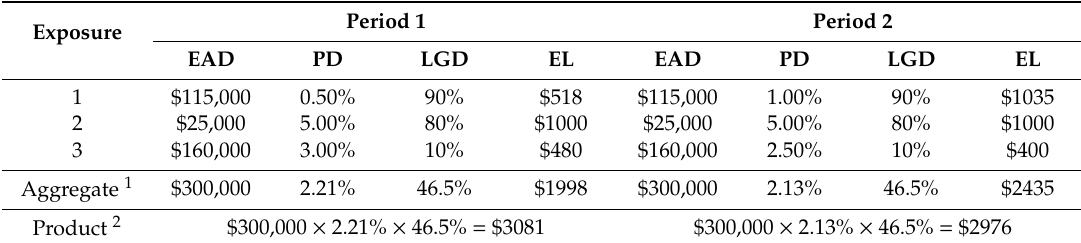
Table 1. Lack of reconciliation for credit risk